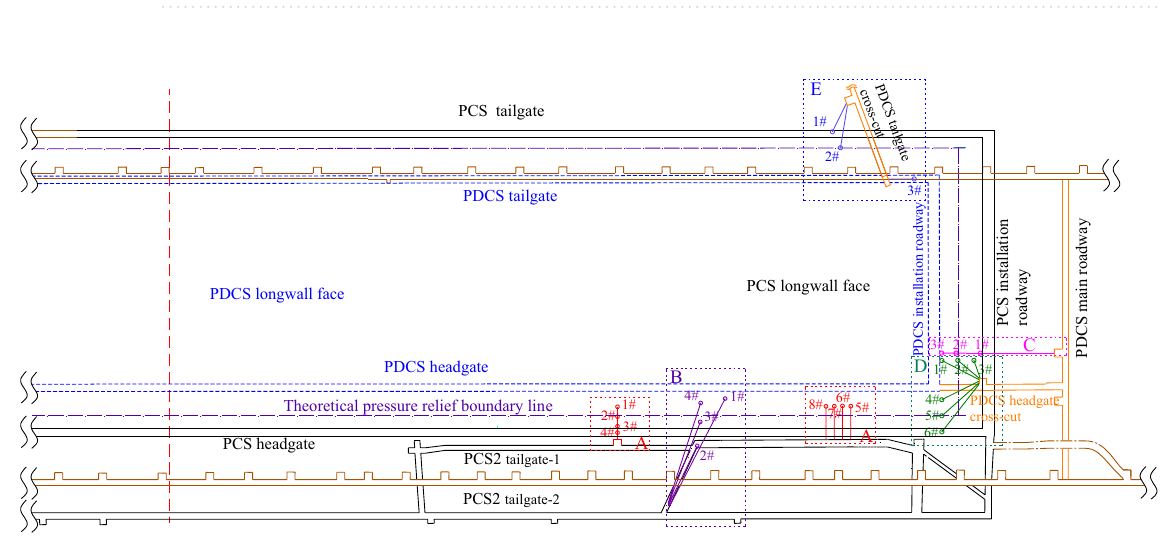
Figure 5. Layout of the test drilling holes in the protected coal